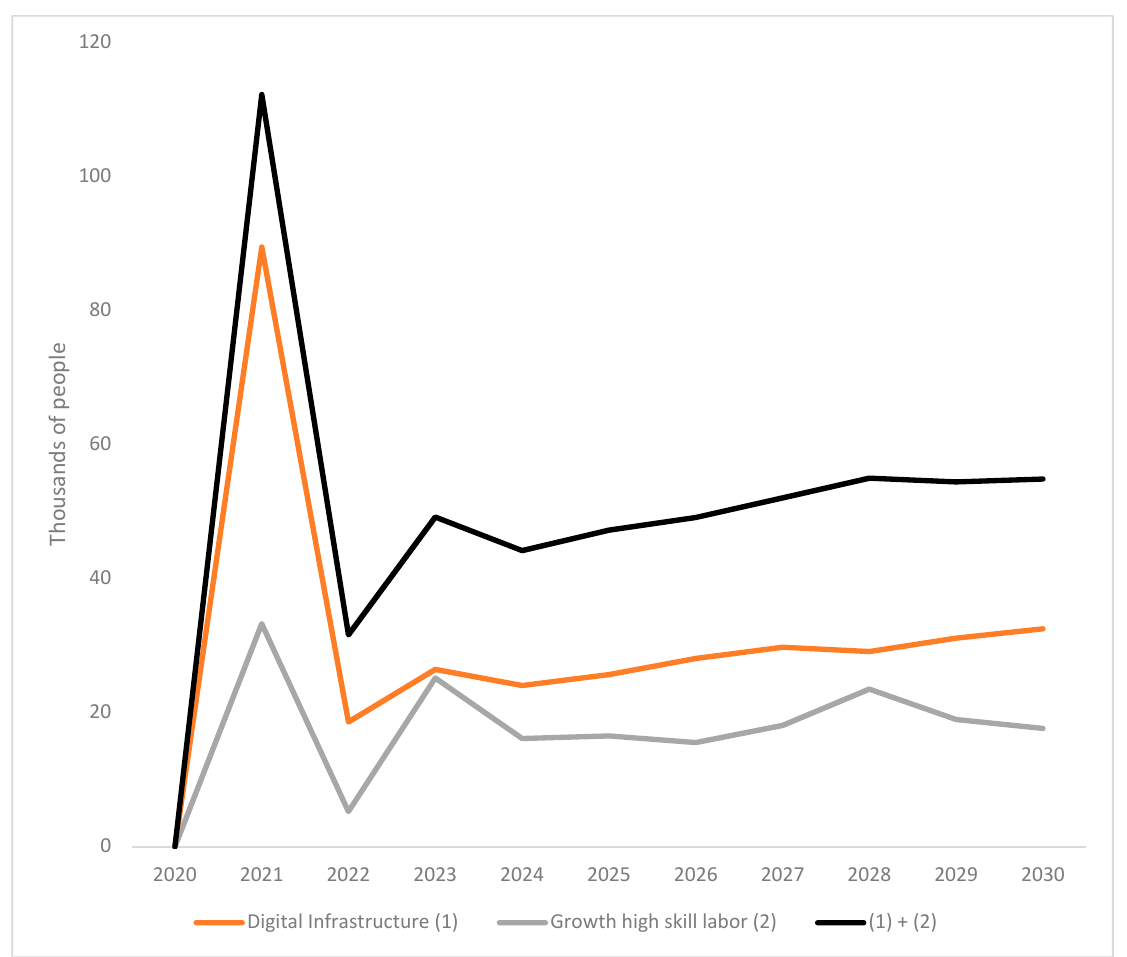
Figure 10. Employment Generation Effects from Digital Infrastructure Development. Source: Authors’ calculations.